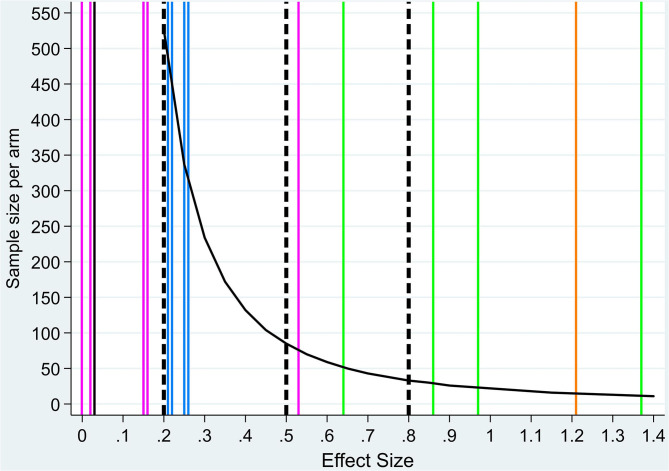
Sample size per treatment arm by effect size values. Sample size by treatment arm by effect size (ES) values (black curve). Dashed vertical lines indicate reference value for small (<0.2), medium (<0.5), and large (>0.8) ESs (17). Colored vertical lines indicate ESBG for each outcome measure: body weight (orange, n = 1), body composition (blue, n = 6, two overlap, one overlaps with metabolism outcome), physical function (black, n = 1), metabolic mediators (pink, n = 6, two overlap), and nutrient components (green, n = 4) (exact values are reported in Table 2). Sample size values for ES < 0.2 are higher than 1,000 and not shown in the figure.